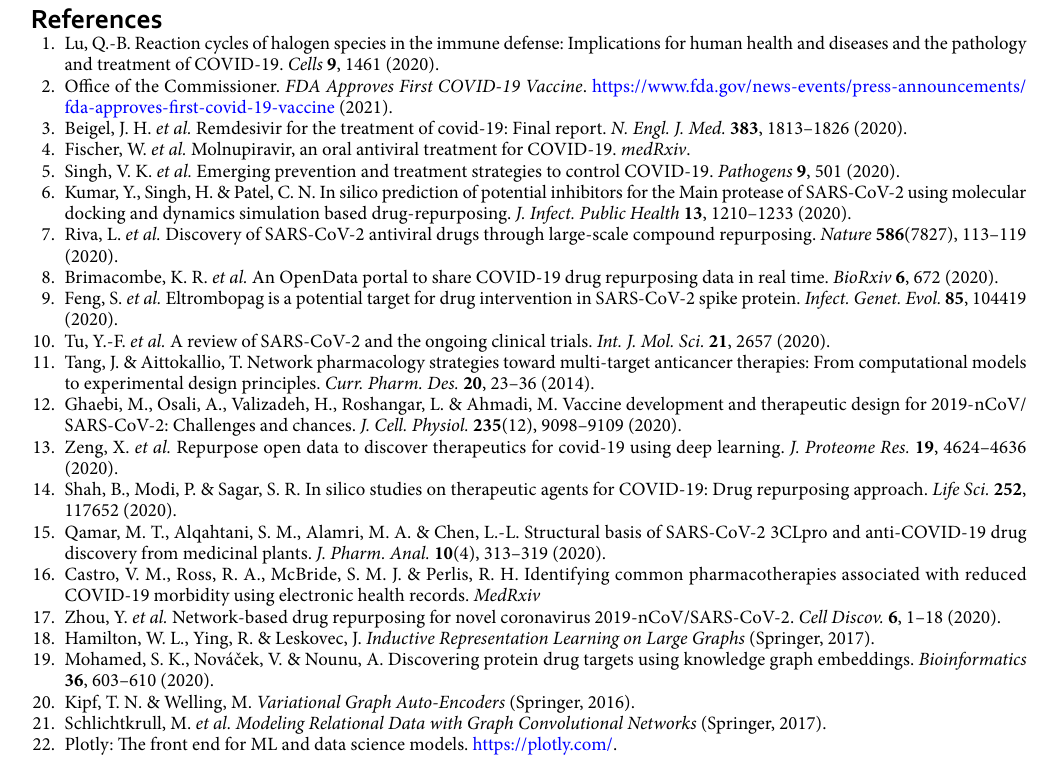
22. Plotly: The front end for ML and data science models. https:// plotly.